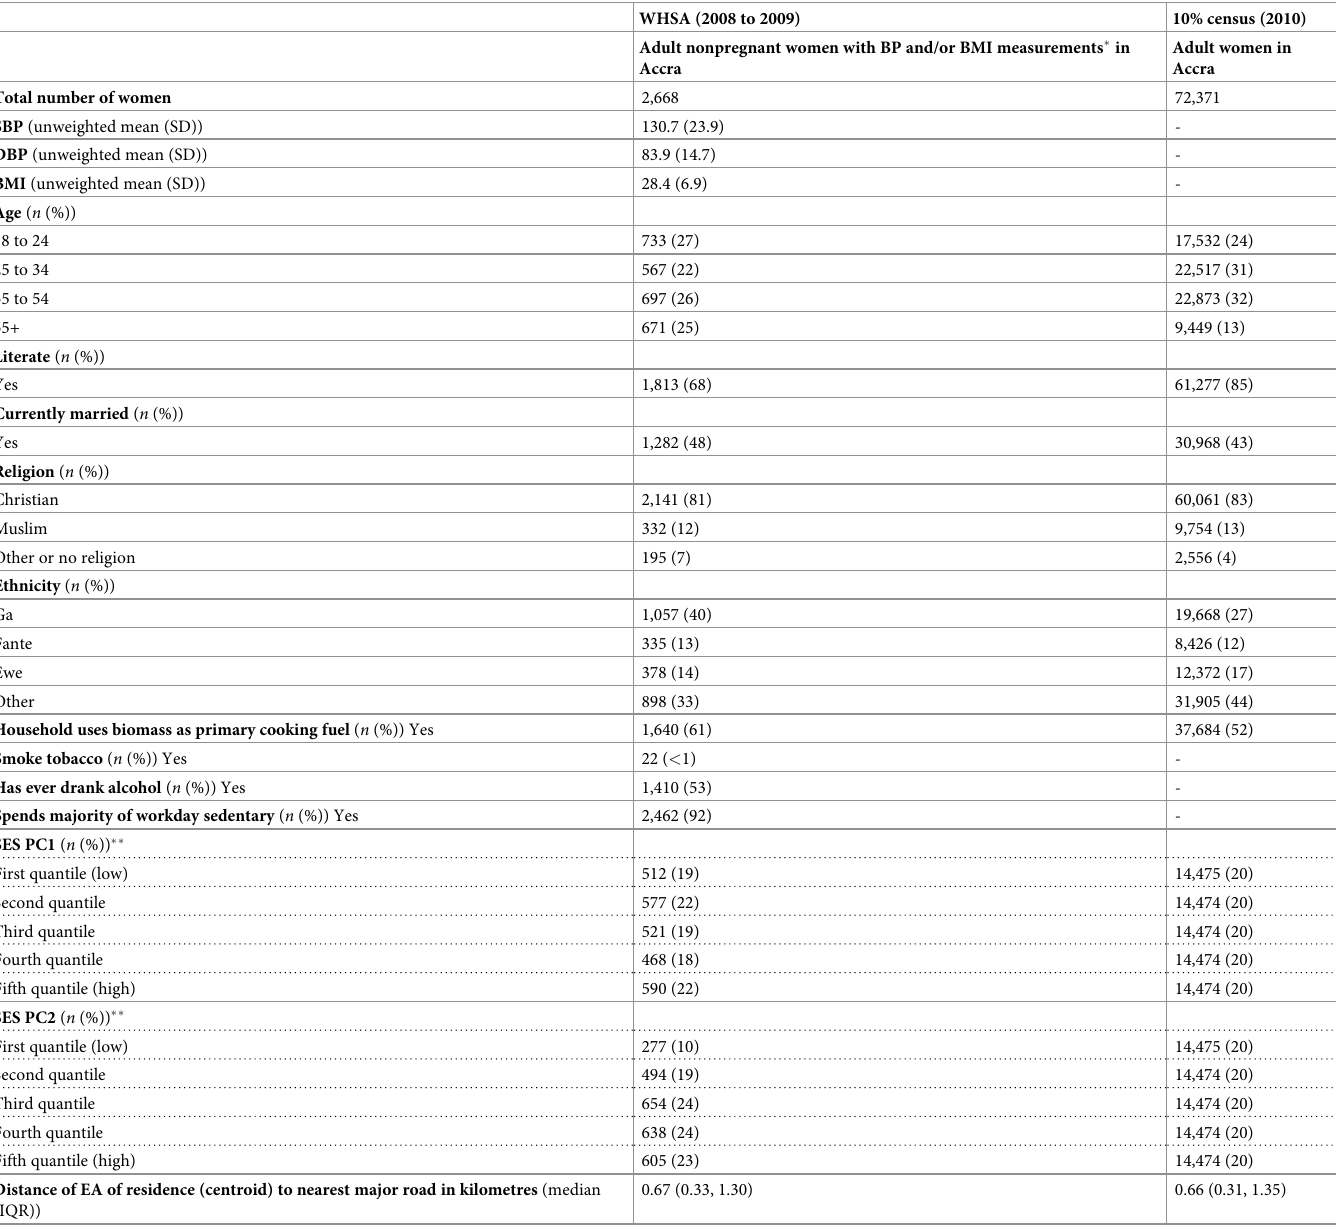
Table 1. Summary statistics of SBP (mm Hg), DBP (mm Hg), BMI (kg/m 2 ), and demographic, behavioural, socioeconomic, and environmental factors in the WHSA and for women of similar ages living in Accra in the 10% random sample of the 2010 Ghana